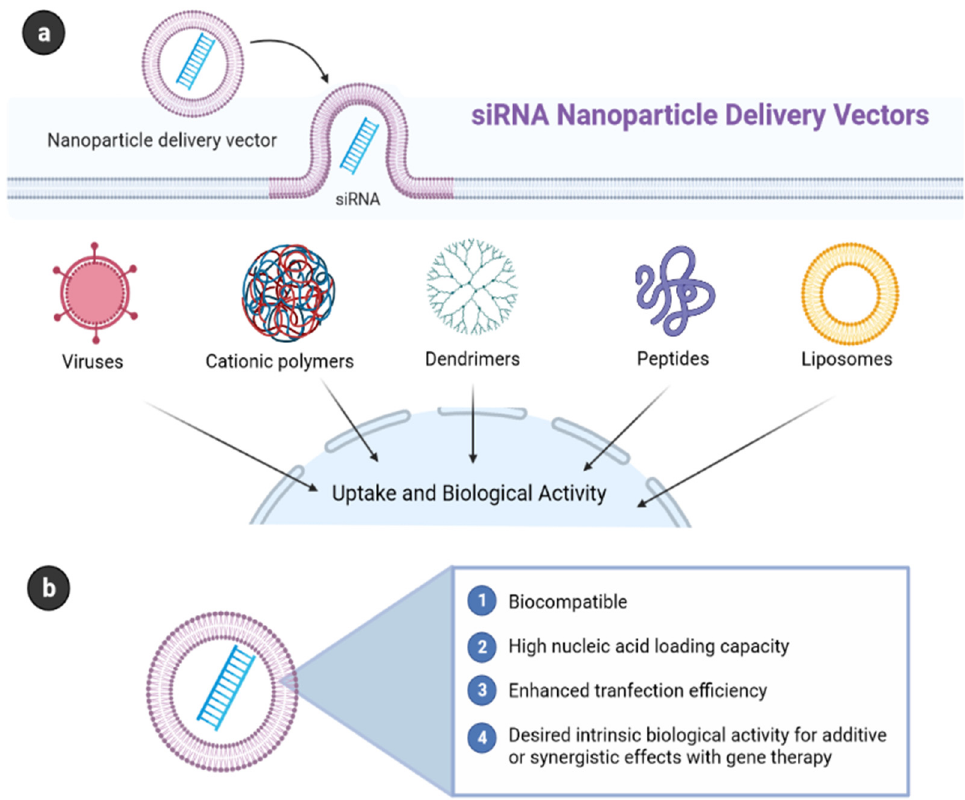
Figure 7. Graphical summary of ( a ) delivery vectors for intracellular delivery of nucleic acids. Apart from viruses, synthetic cationic vectors such as cationic polymers, branched dendrimers, cell-penetrating (CP) peptides, and cationic liposomes can be used to deliver genes into cells; ( b ) Properties of an engineered synthetic vector for gene therapy in the future. In addition to exhibiting good biocompatibility, loading capacity, and transfection efficiency, a future synthetic vector may also be designed to have a desired intrinsic biological activity that would enhance the effects of gene therapy [own drawing].